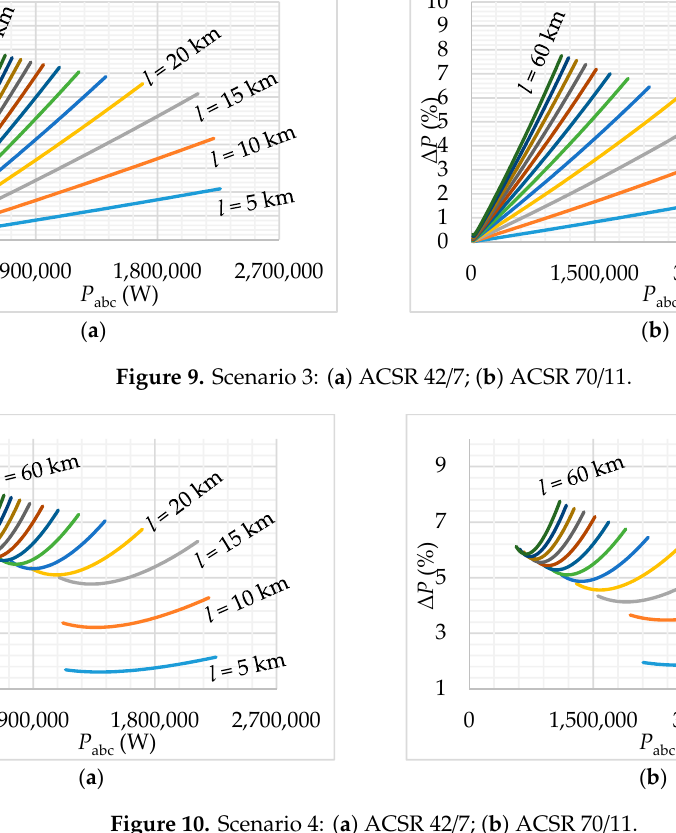
Figure 8. Scenario 2: ( a ) ACSR 42/7; ( b ) ACSR 70/11.